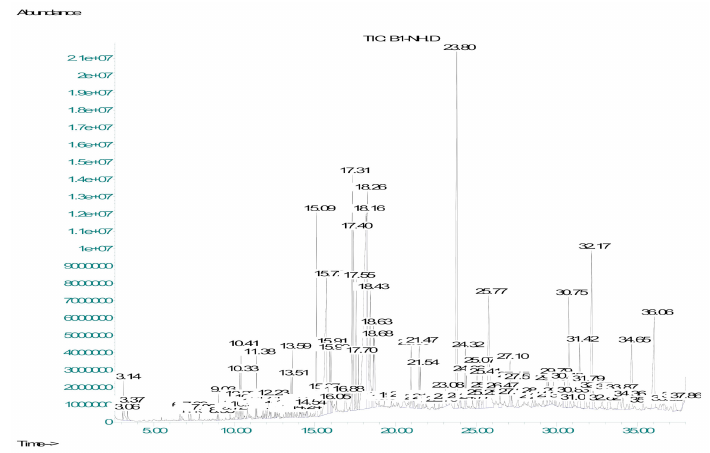
Figure 2. GC-MS chromatogram of the n -hexane fraction in Dracaena reflexa .